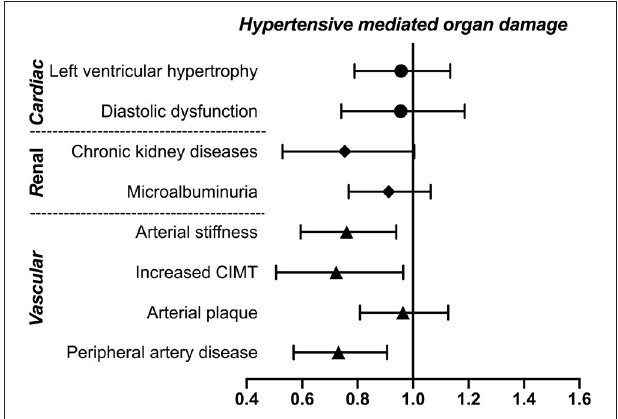
FIGURE 1 | Association of weekly walking activity with asymptomatic HMOD. Weekly walking activity was defined as walking more than 10min at a time per week. The ORs and 95% CI of walking activity were presented after adjustment for cardiovascular risk factors (including age, gender, smokers, body mass index, systolic blood pressure) and concomitant diseases (hypertension, diabetes mellitus, coronary heart disease) using multivariate logistic regressions. CIMT, carotid intima–media thickness; HMOD, hypertensive mediated organ damage; OR, odds